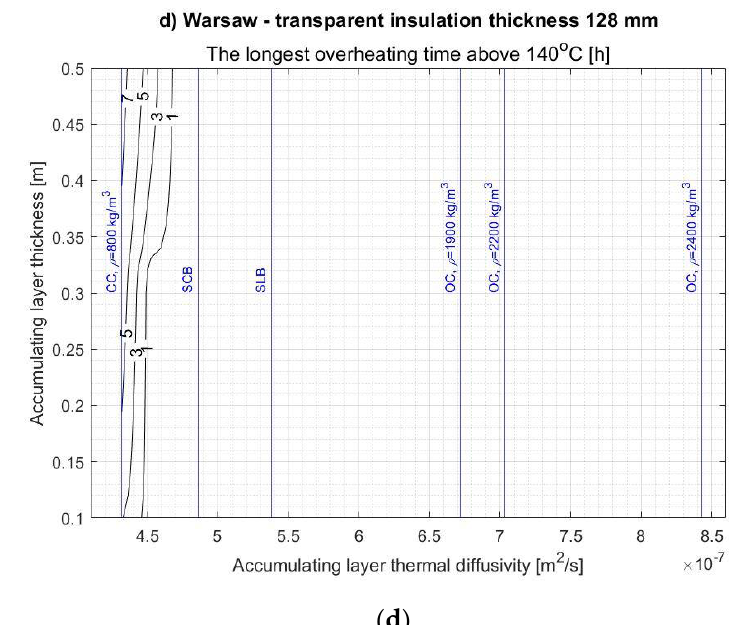
Figure A6. Contour graphs characterizing the SW basic parameters in a function of AL thermal diffusivity and thickness for the whole heating season: ( a ) the heat balance of the SW’s unit area, ( b ) the heating time, ( c ) the mean time lag of the maximum temperature on the absorber and SW’s internal surface during the day, ( d ) the longest overheating time above 140 °C in the TI. TI thickness: 128 mm. Location: Warsaw.